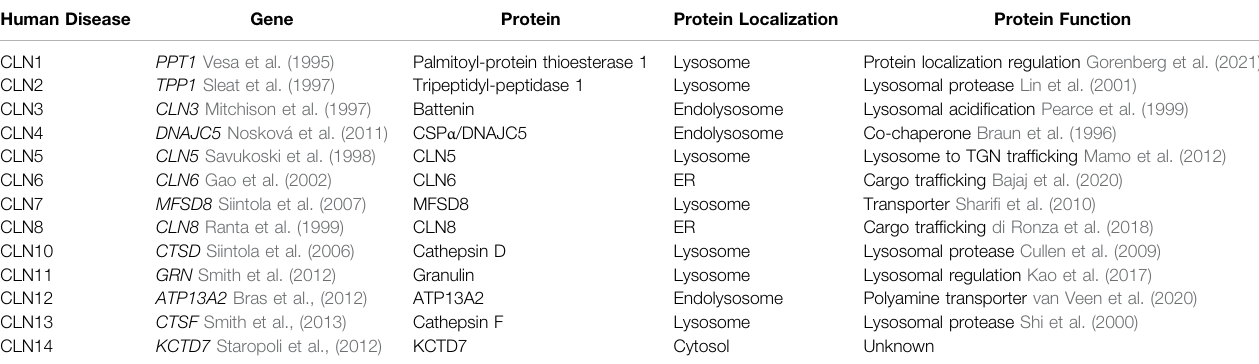
TABLE 1 | A list of genes associated with various forms of CLN. Please add a reference column. Human